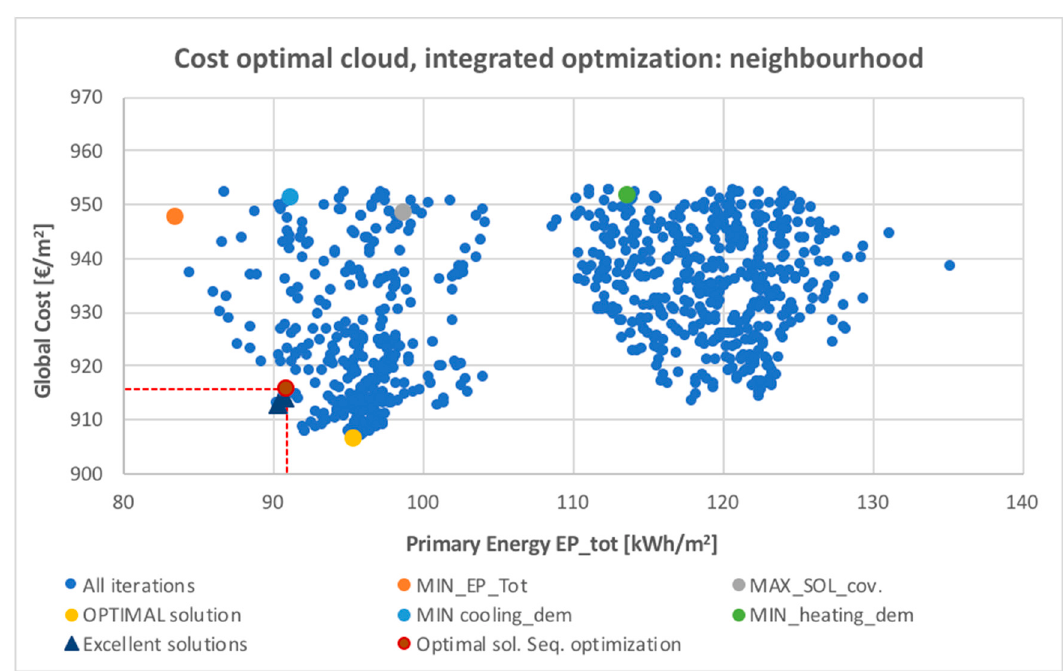
Figure 13. Cost-optimal neighborhood: integrated optimization and financial objective. Appl. Sci. 2019 , 9 , x FOR PEER REVIEW